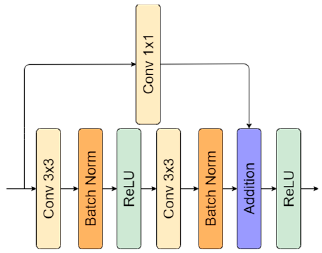
Figure 4. Residual connection representation: 1 × 1 convolutional operation used to adjust number of features.